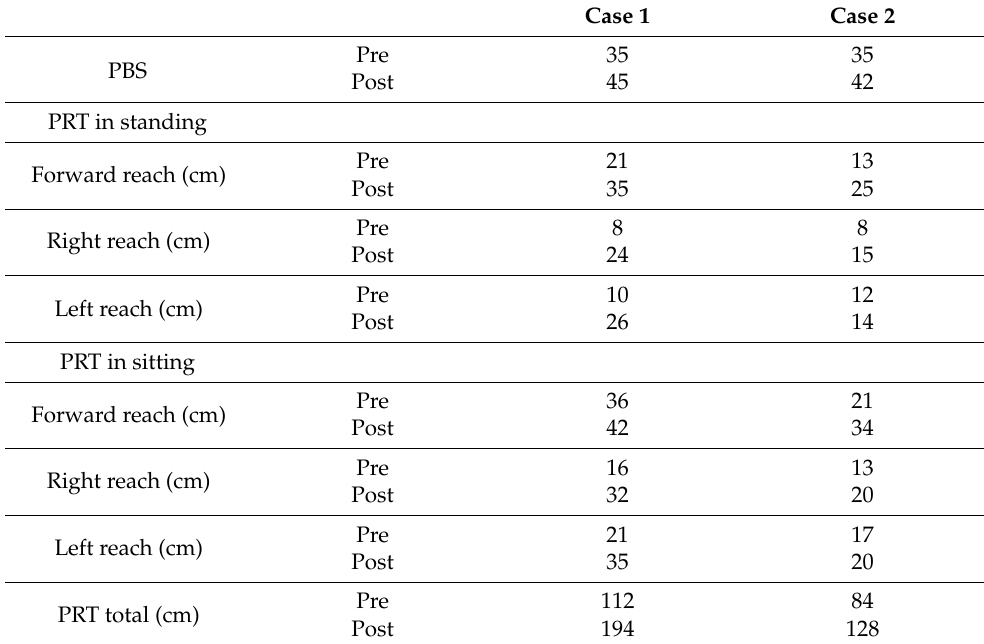
Table 4. Changes in PBS and PRT after